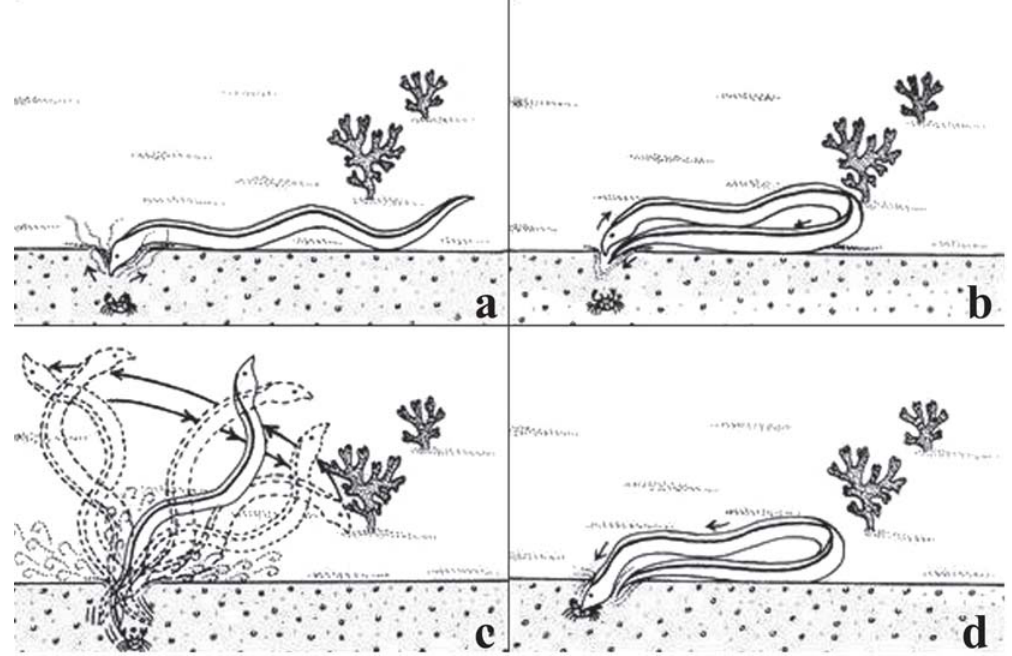
Fig. 1. Capture sequence of Myrichthys ocellatus involving head and tail: (a) initial scattering movements with the head; (b) tail taking over the position of the head; (c) widening hole with the tail; (d) moment of prey capture. Illustrated by Francisco